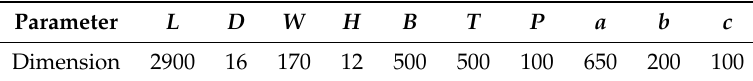
Table 5. Optimized dimensions of the proposed